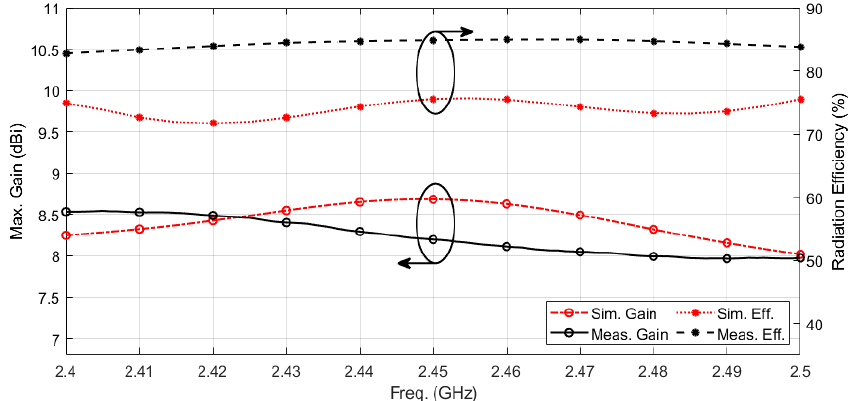
Figure 4. Electromagnetically coupled microstrip patch antenna’s simulated and measured Gain and Radiation Efficiency.